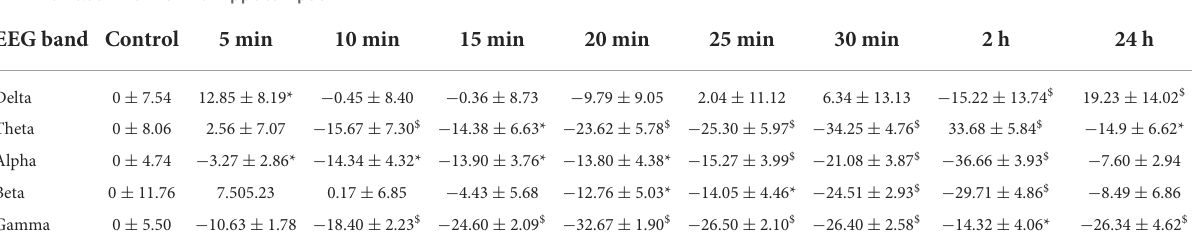
TABLE 3 Quantitative EEG hippocampus.